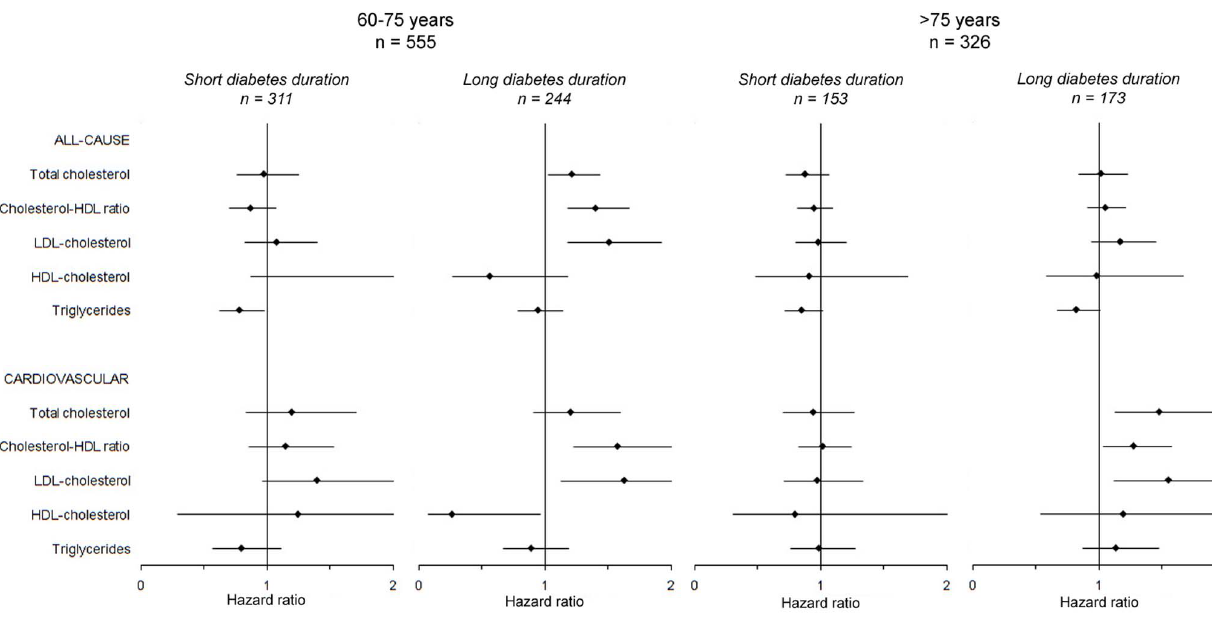
Figure 4. Combined forest plot: short versus long diabetes duration. Hazard ratios and the 95% confidence intervals of the various lipid profile indices stratified for diabetes duration ( , median value versus median value and higher), adjusted for the selected confounders.